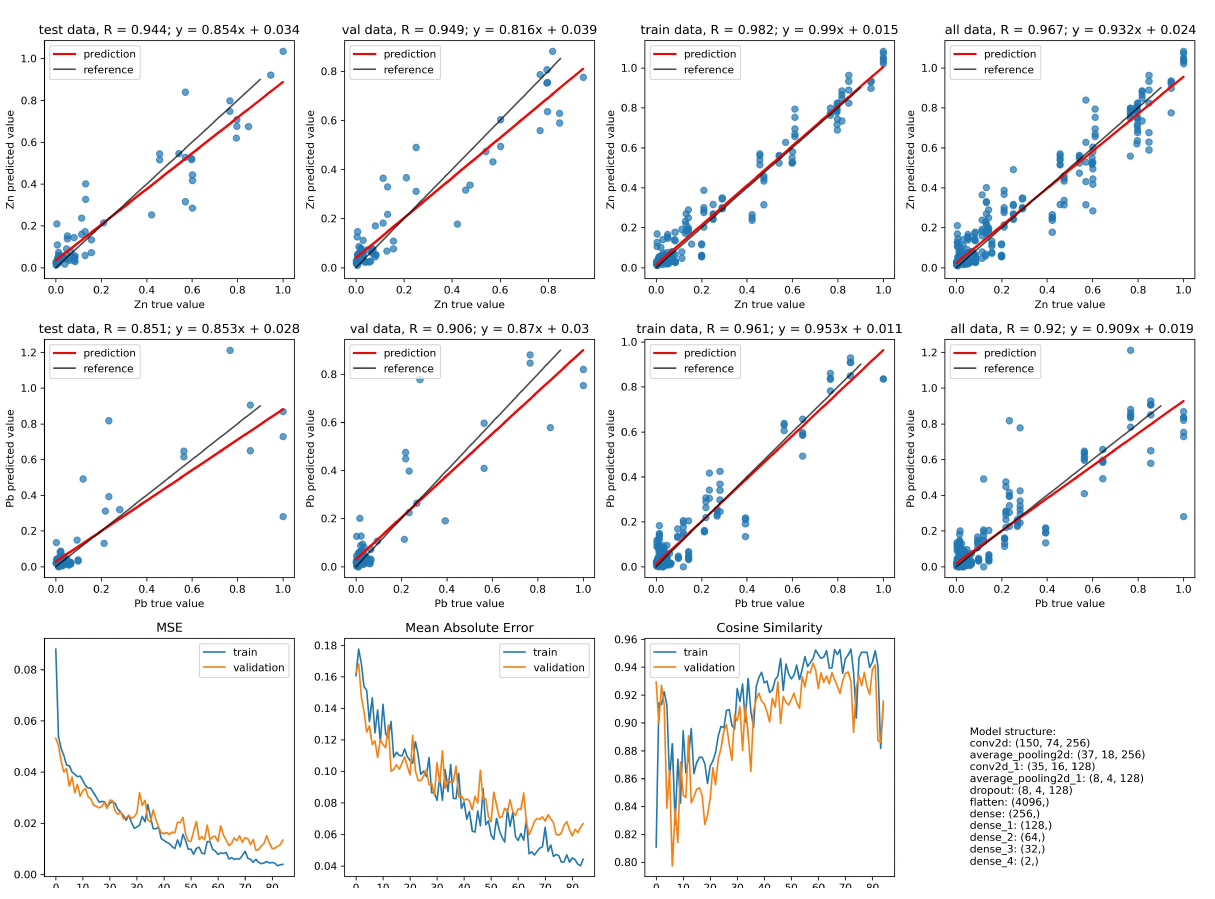
Figure 5. Best results obtained by the network structure with index 10. The top two rows represent the scatter plots with true values of metal concentrations on the x-axis and predicted values of metal concentrations on the y-axis. the first row corresponds to zinc, while the second row corresponds to lead. Results for test validation, training and full dataset are presented in the first, second, third and fourth columns, respectively (counting from the left). Finally, in the bottom row, the values of mean absolute error, mean squared error, cosine similarity and general model structure are